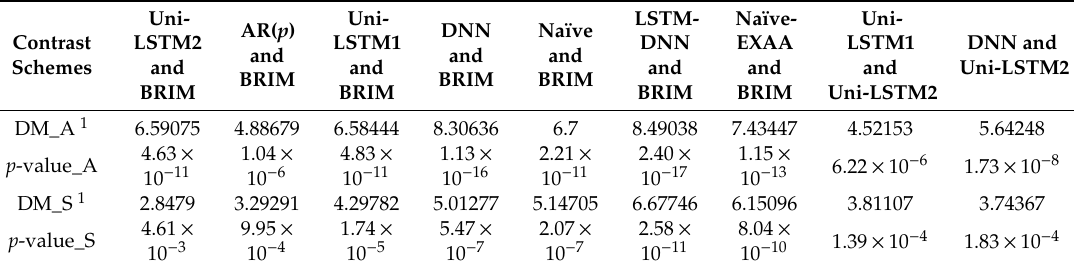
Table 3. Results of the Diebold-Mariano (DM)